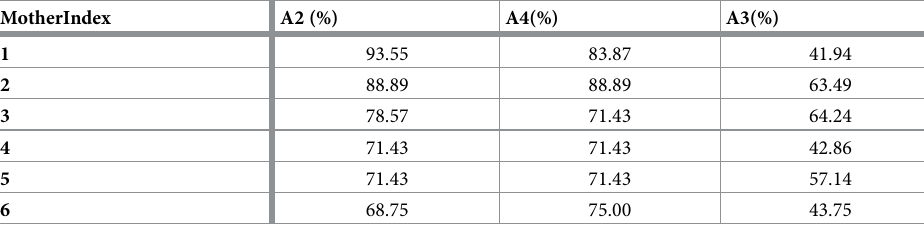
Table 4. True positive rate of Algorithm 2 to 4 on individual mothers.